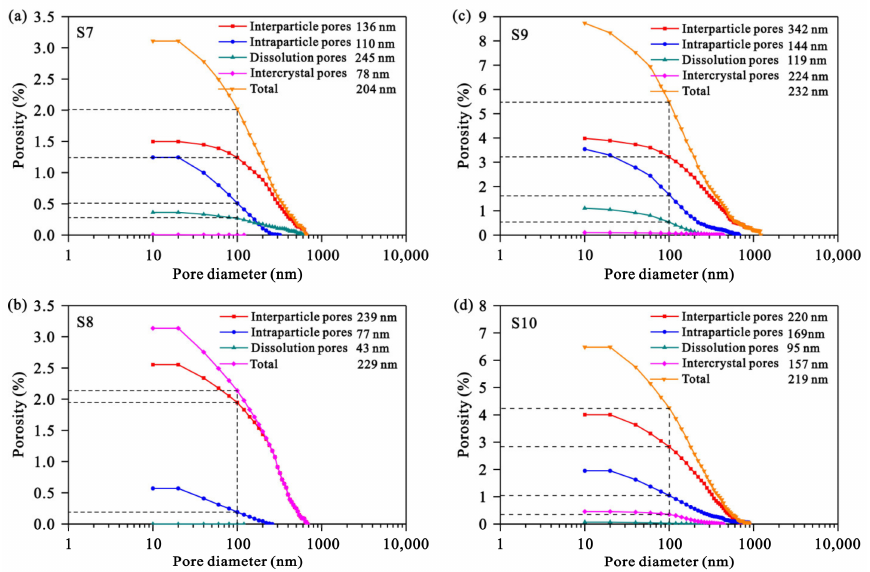
Figure 14. Pore size distributions in calcareous shales: ( a ) S7; ( b ) S7; ( c ) S9; ( b ) S10.